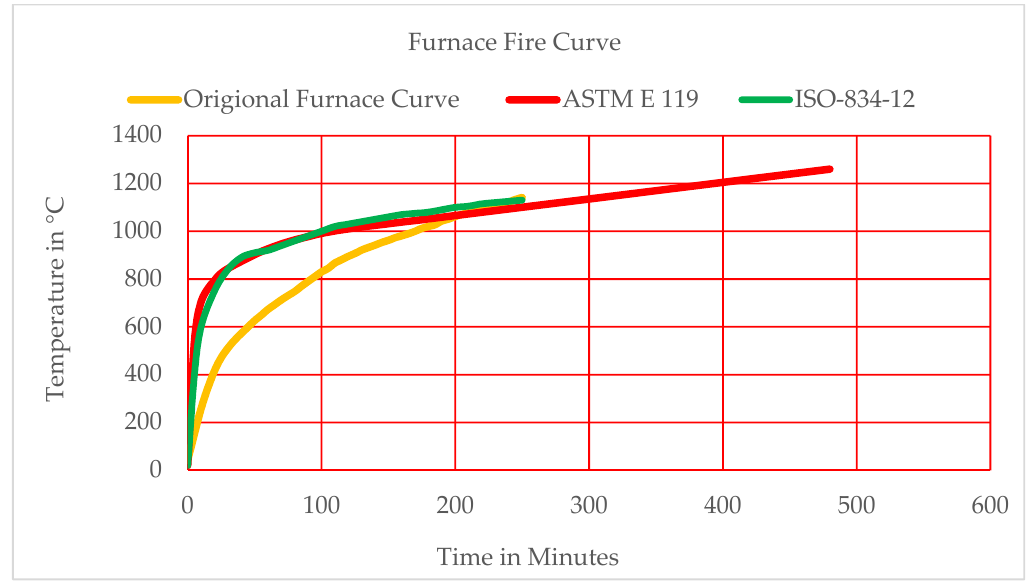
Figure 3 . Used furnace temperature variation times in this present study. Figure 3. Used furnace temperature variation times in this present